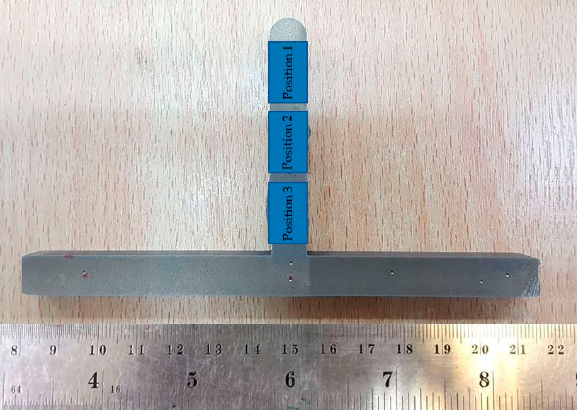
Figure 6. Schematic illustration of microhardness measurement on the profile of the microhardness of layer bands.